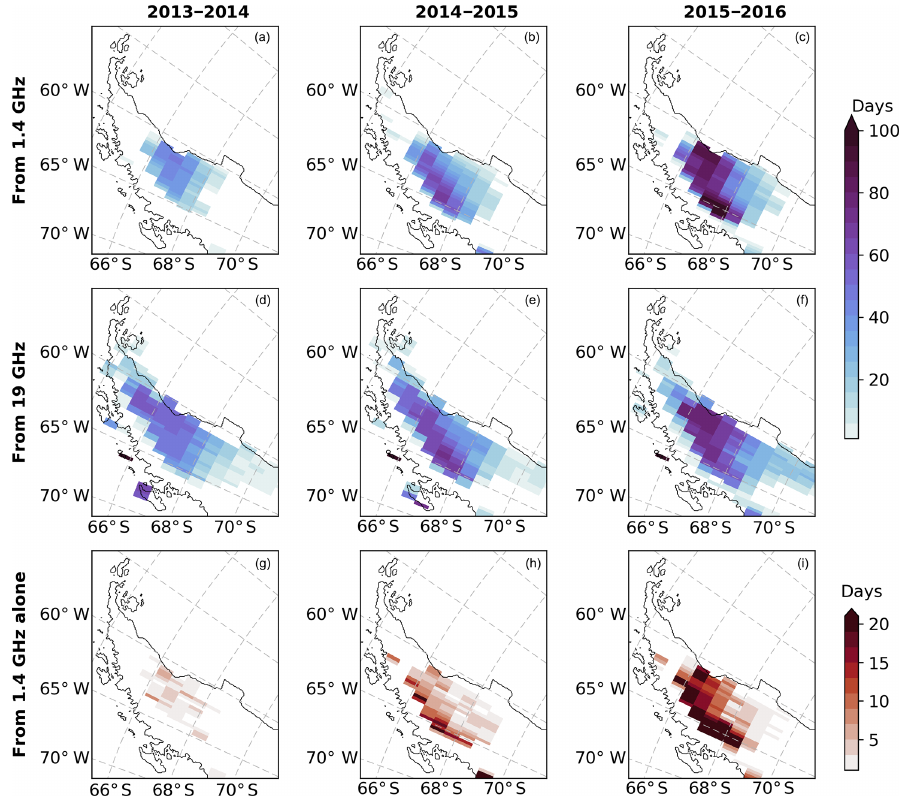
Figure 5. Annual melting duration (days) over the Antarctic Peninsula detected with observations (a–c) at 1.4GHz and (d–f) at 19GHz from 2013–2014 to 2015–2016. (g–i) Number of days detected as melting at 1.4GHz but dry at 19GHz.